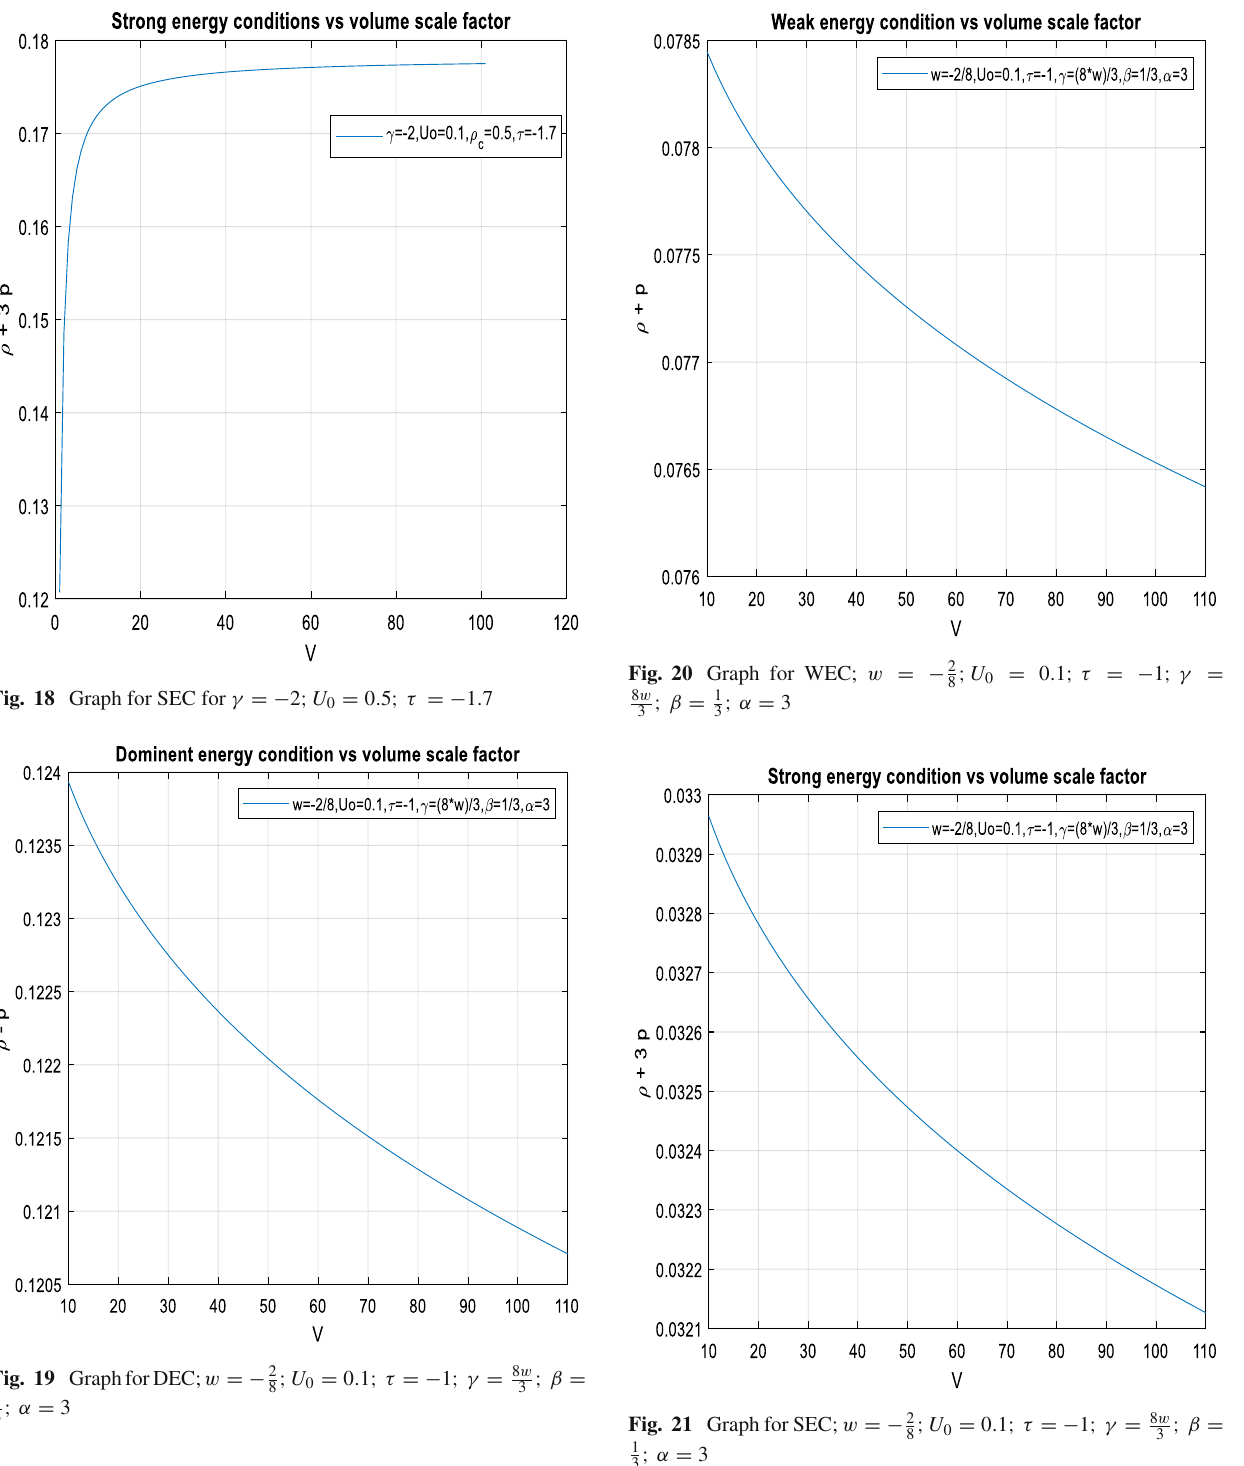
; U = 0 . 1 ; τ = − 1 ; γ = 8 w 0 8